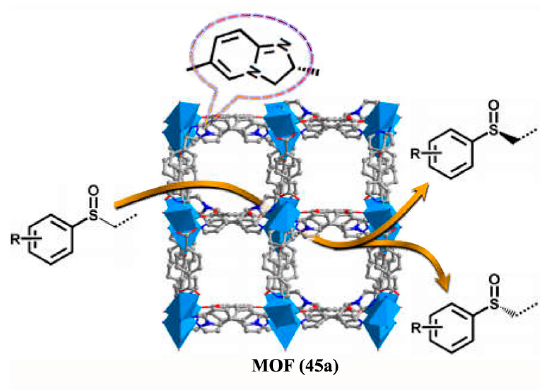
Figure 15. Enantioseparation of racemic sulfoxides by a Zn-DHIP MOF ( 45a ). Reproduced from [110] with permission from the American Chemical Society.